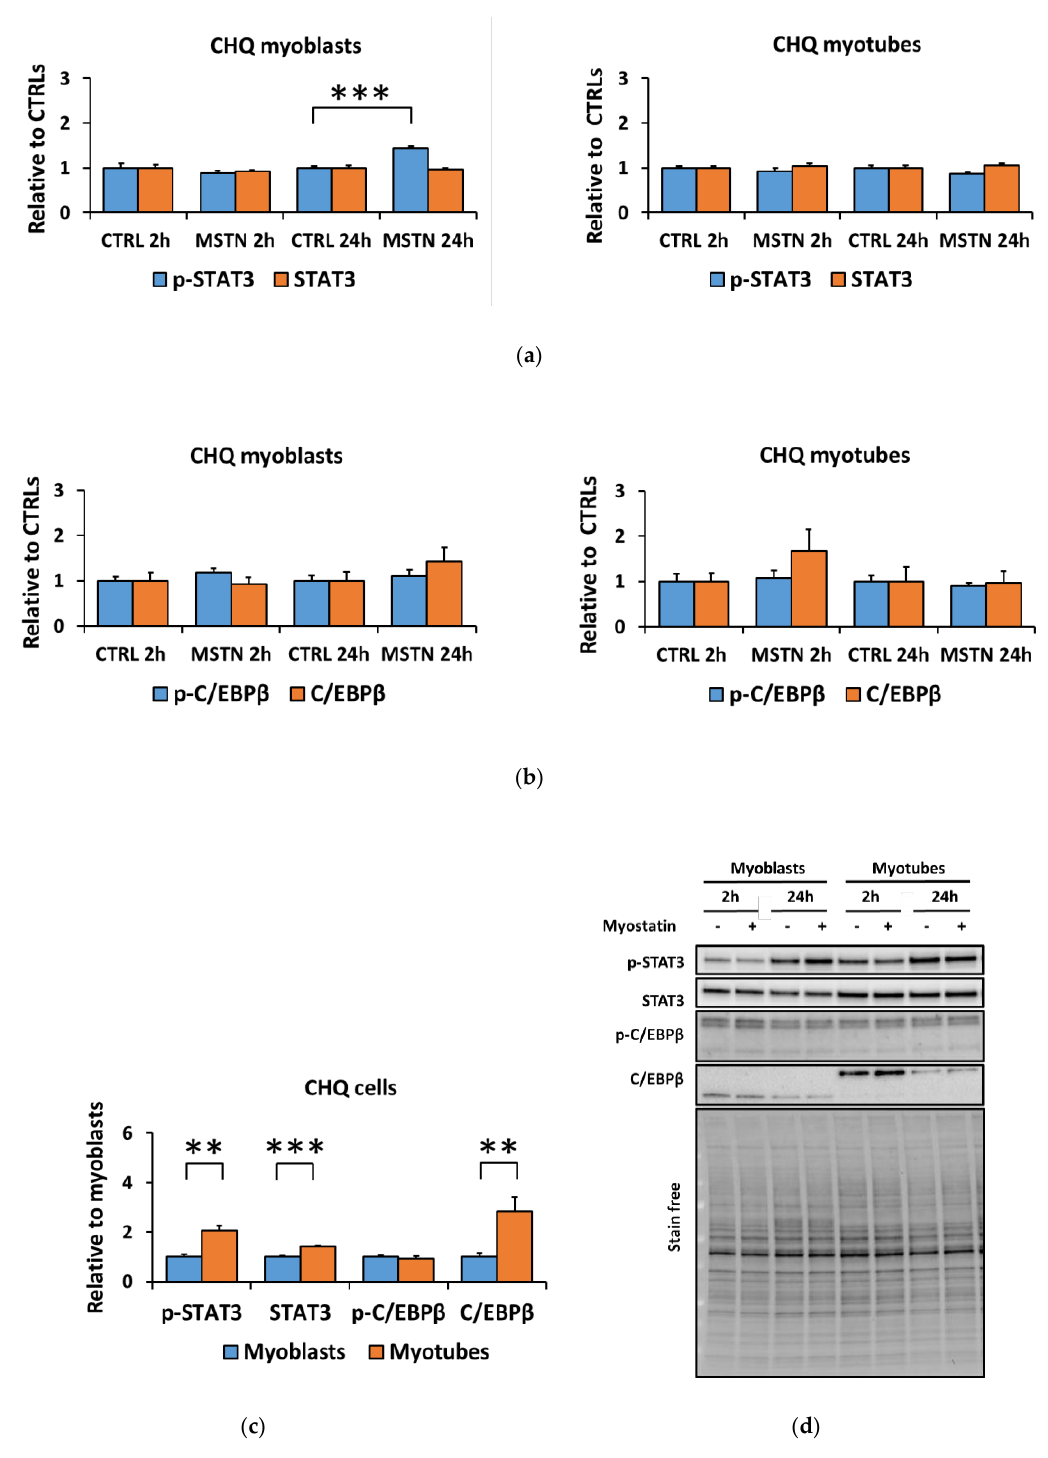
Figure 8. Myostatin administration had a minor impact on inflammatory signaling in CHQ cells. ( a ) Phosphorylated STAT3 Tyr705 and total STAT3 in myoblasts and myotubes. ( b ) Phosphorylated C / EBP β Thr235 and total C / EBP β in myoblasts and myotubes. In the figures, the values are presented as normalized to CTRL = 1. ( c ) Nontreated CTRL myoblasts and myotubes of the 2-h and 24-h time-points were pooled and the values are presented as normalized to myoblasts = 1. ( d ) Representative blots. In A–B, N = 6 per group. In C, N = 12 per group. ** and *** = p < 0.01 and p < 0.001, respectively. CTRL (-) = control group, MSTN ( + ) = myostatin group.